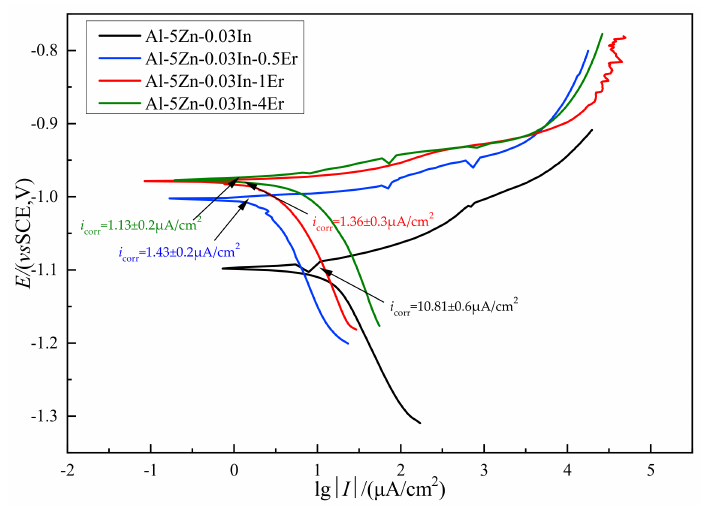
Figure 6. Polarization curves of Al–5Zn–0.03In– x Er